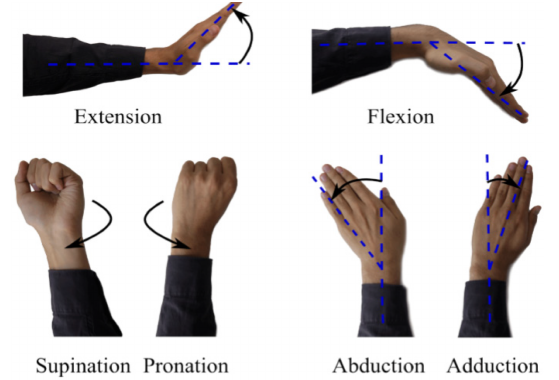
Figure 1. DOF of wrist and forearm (Omarkulov et al., 2016).